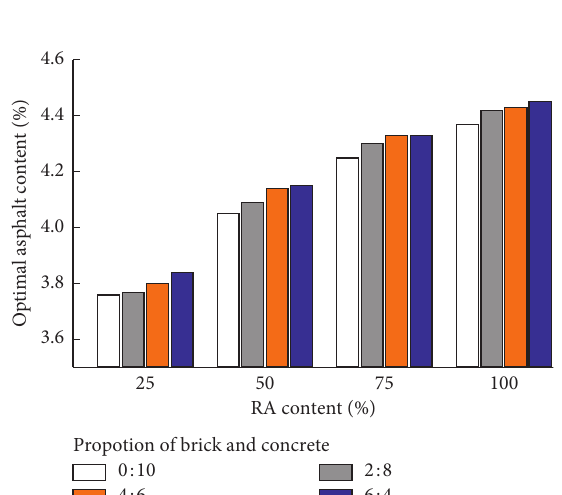
Figure 4: Marshall test results of asphalt mixtures with 25% RCA.